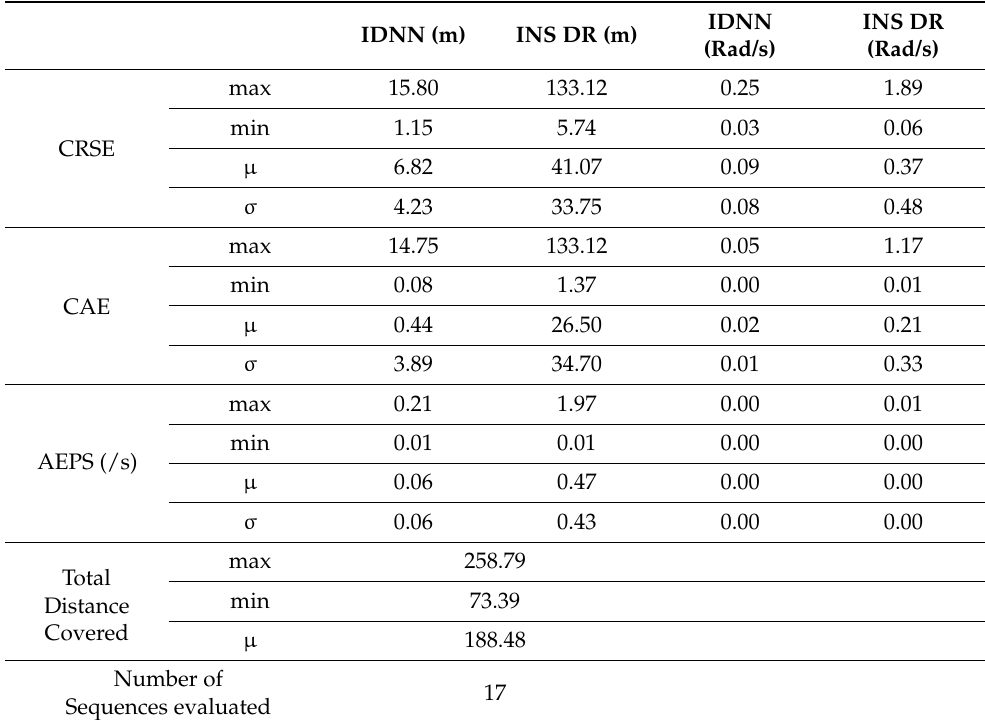
Table 12. Showing the performance of the IDNN and INS DR on the hard brake